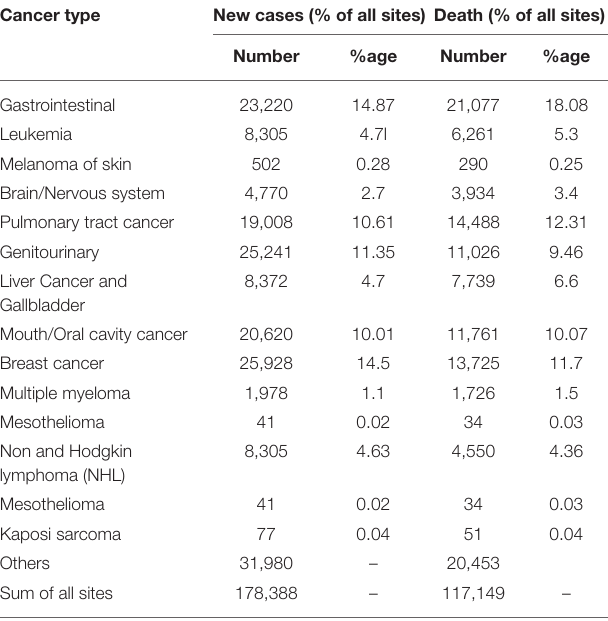
TABLE 1 | New cases and deaths for different types of cancer worldwide. (Data have been acquired from Global Cancer Statistics 2020). Cancer type